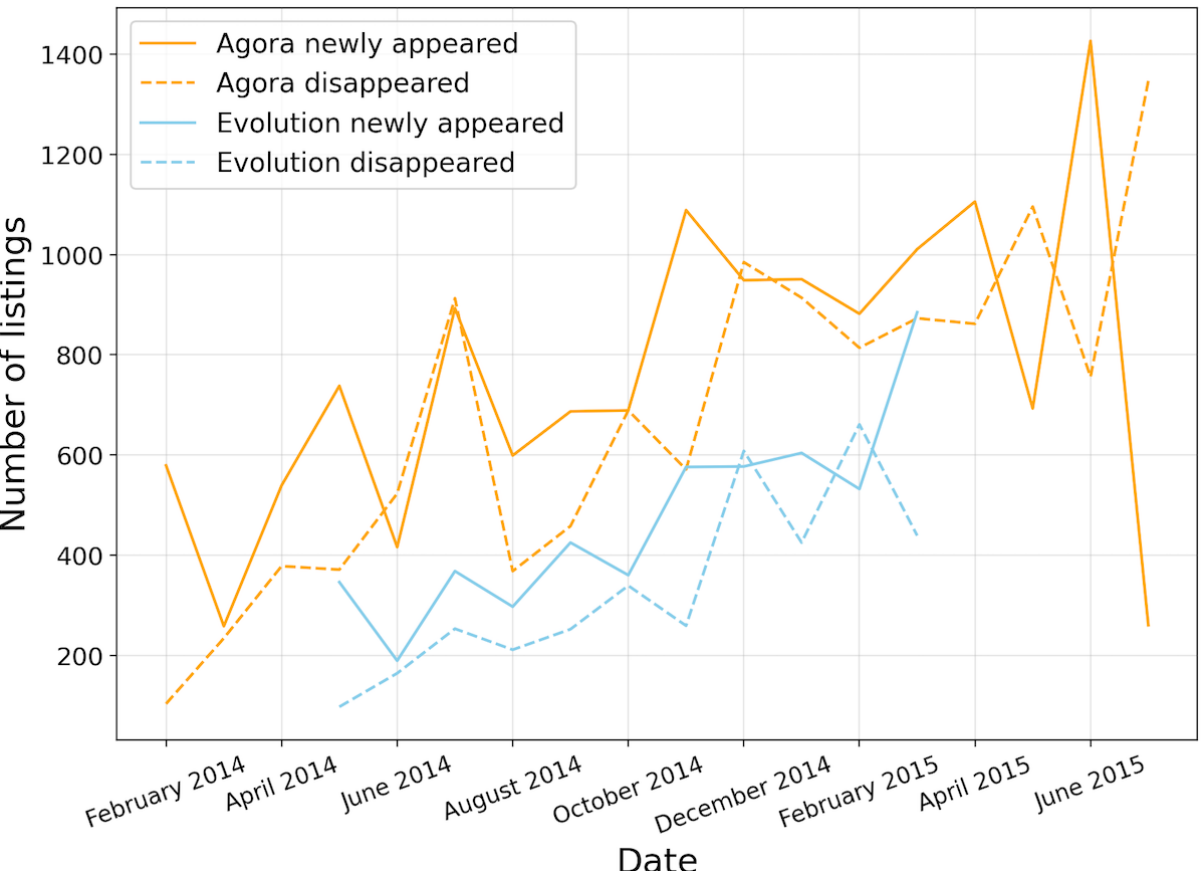
Figure 5. Number of monthly newly-appeared and disappeared listings in the marketplaces Agora and